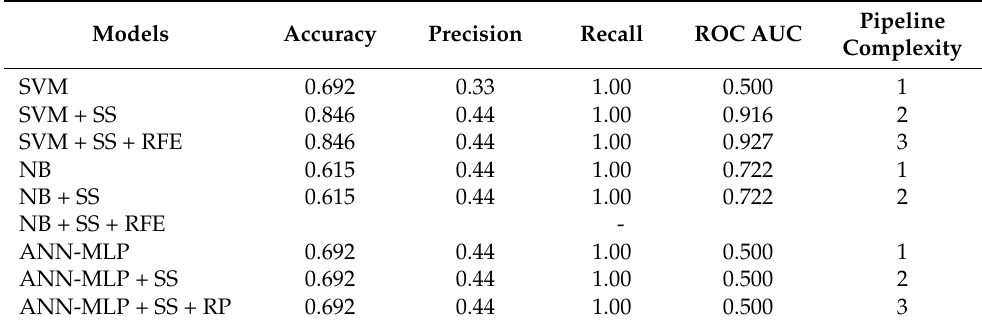
Table 7. Comparative analysis of the grid search optimization of selected ML algorithms with SS and RFE pre-processing operators for each model. Models Accuracy Precision Recall ROC AUC